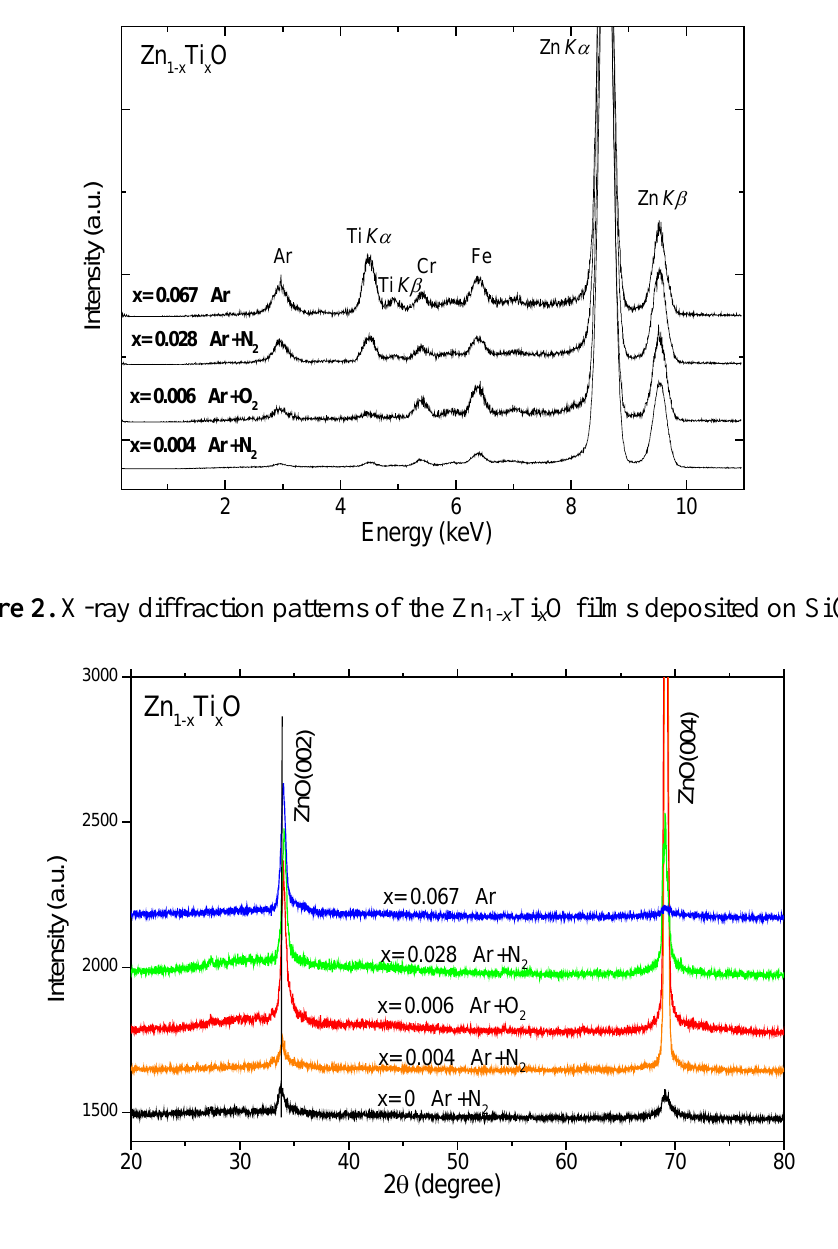
Figure 3 compares the normalized Ti K -edge X-ray absorption near-edge spectroscopy (XANES)